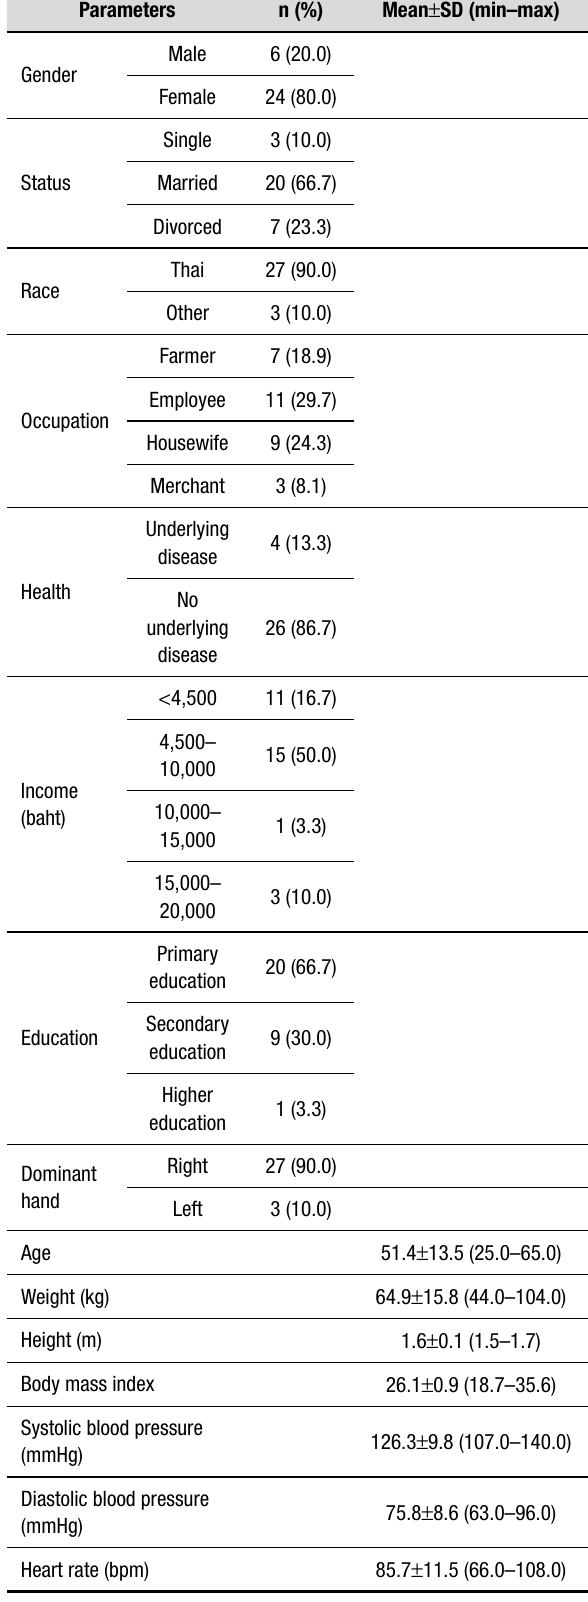
Table 1. Demographic data of participants